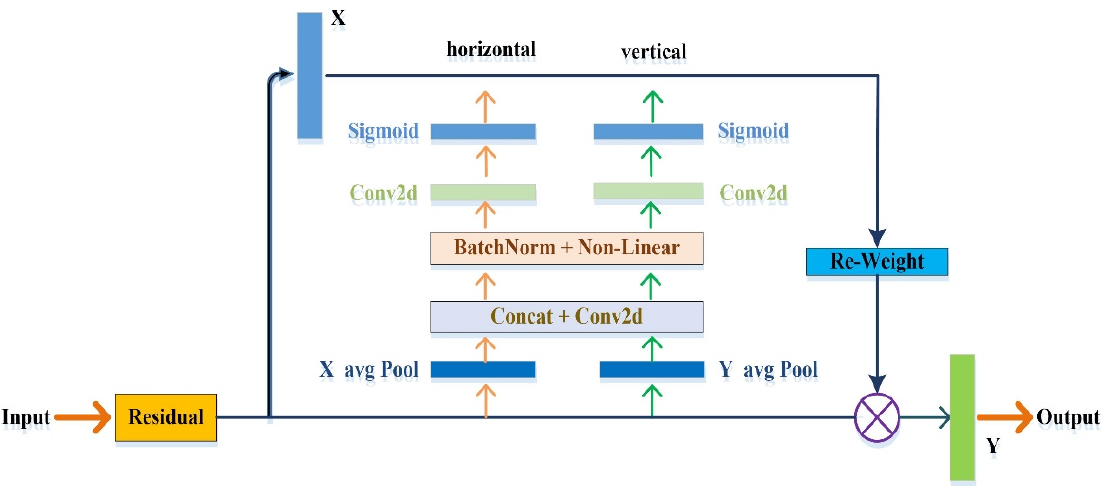
Figure 4. The CA module.